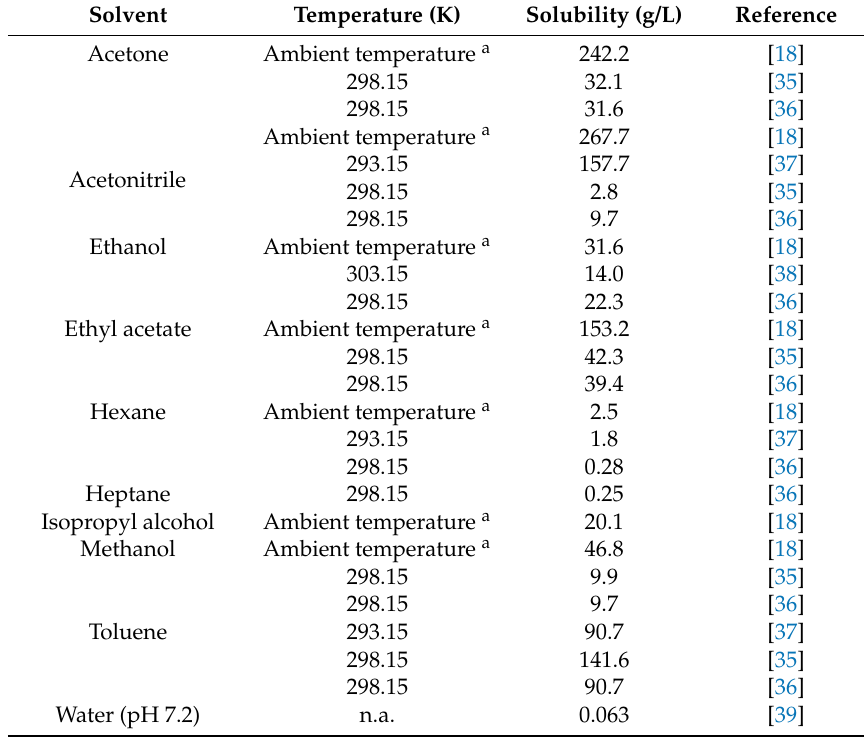
Table 3. Comparison of the solubility of artemisinin in some selected solvents.